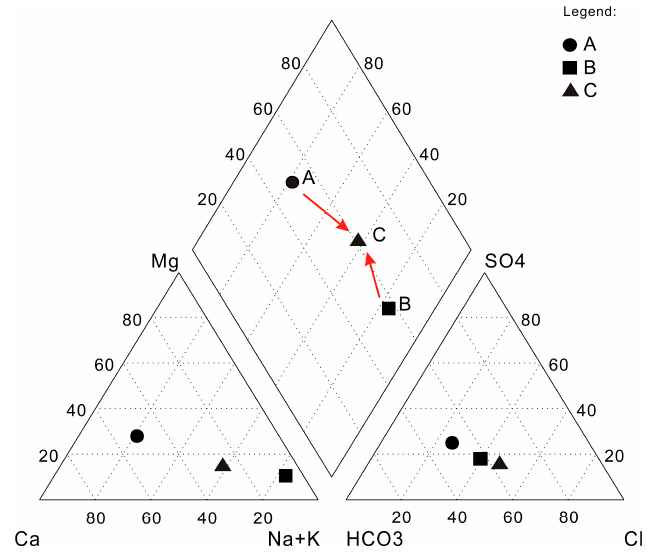
Figure 4. Graphical method by piper diagram, where A and B are parent solutions and C is the